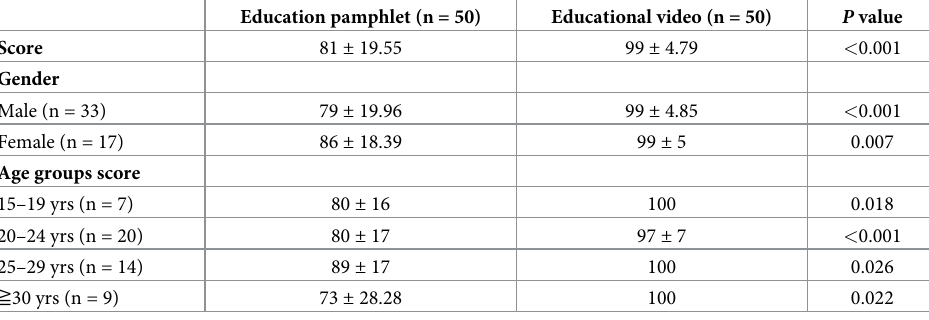
Table 2. Test scores post-pamphlet and educational video.